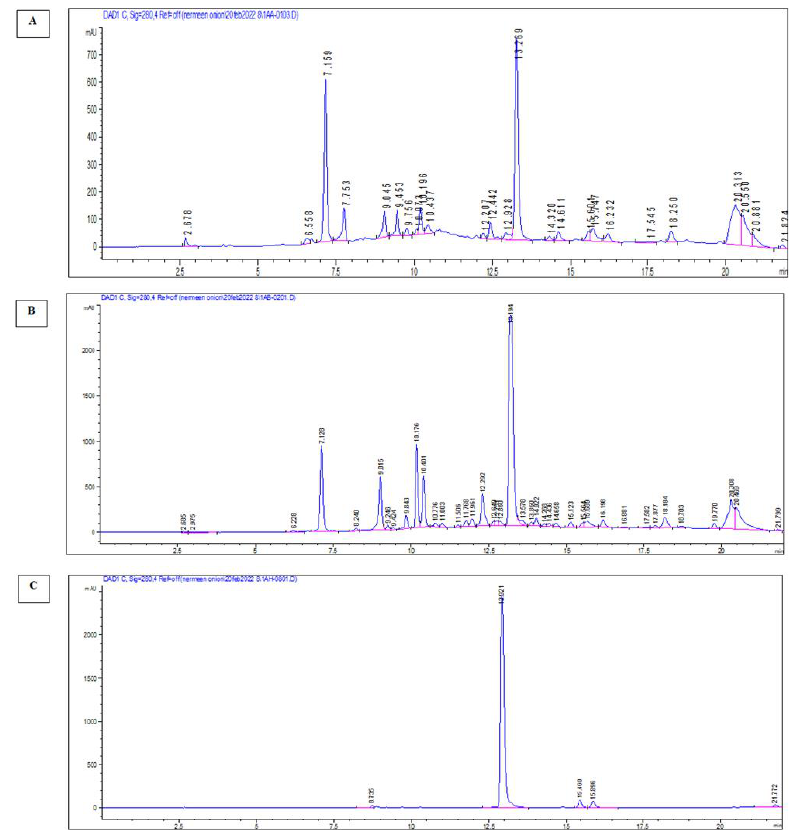
Figure 3. HPLC chromatograms of total extract ( A ), flavonoid-rich fraction ( B ), and quercetin std ( C ) at 280 nm. 3. Discussion The development of multidrug resistance between clinical pathogens has been re- ported to be coupled with biofilm formation [11]. The predominance of Staphylococcus re- sistant bacteria in hospital and community infections, especially in immunocompromised patients, has motivated many researchers to investigate these bacteria. Genus Staphylococ- cus bacteria are known to be able to develop resistance against many antibiotics, which could delay the patient ’ s cure and cause high morbidity and mortality rates. Staphylococcus aureus is the major cause of bacterial infections in the genus Staphylococcus . The vancomy- cin antibiotic is the only one that can be used against infections of methicillin-resistant